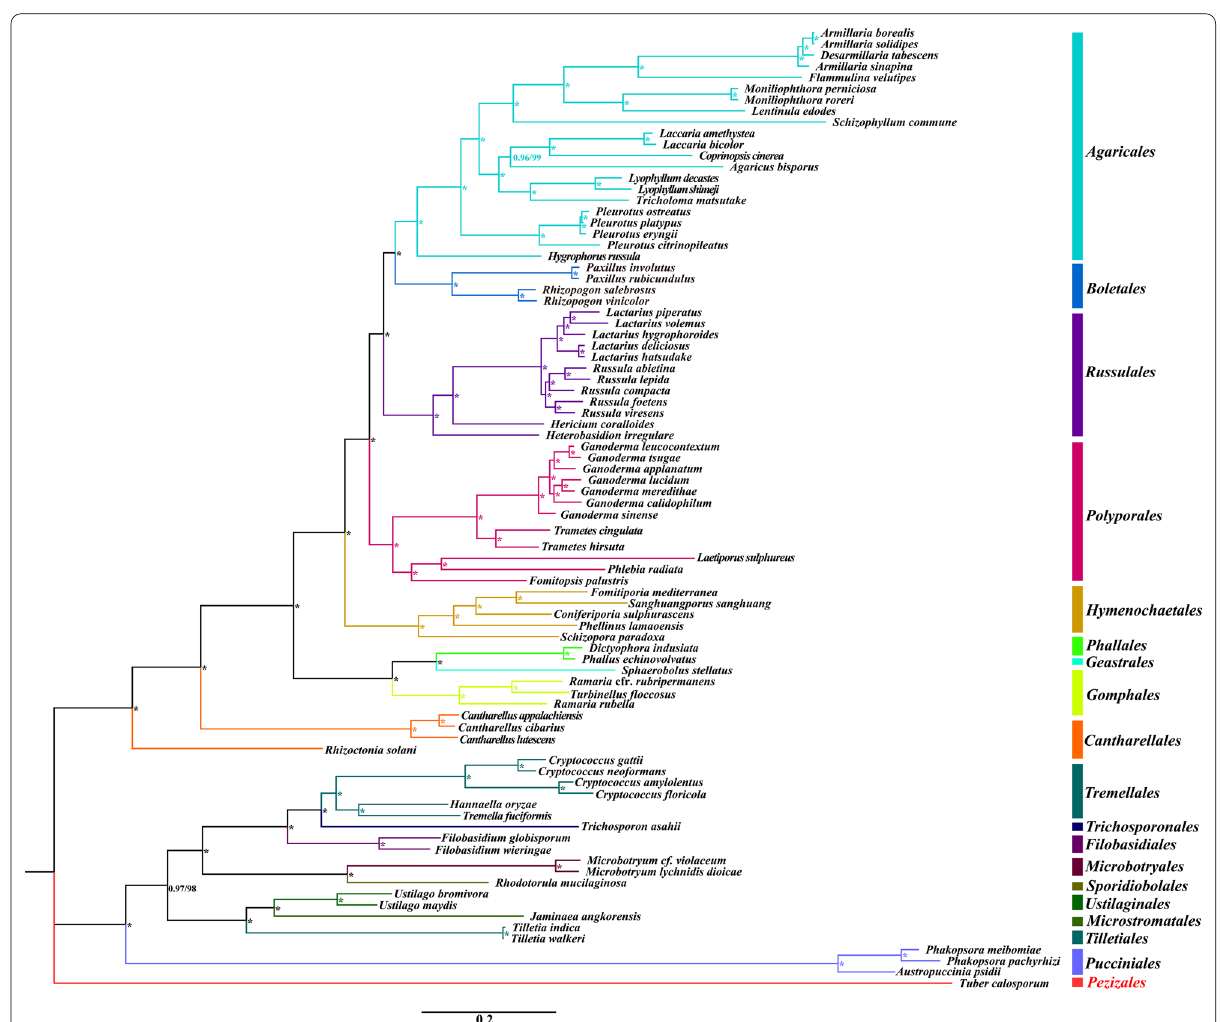
Fig. 9 Molecular phylogeny of 84 Basidiomycota species based on Bayesian inference (BI) and Maximum Likelihood (ML) analysis of 14 protein coding genes. Support values are Bayesian posterior probabilities (before slash) and bootstrap (BS) values (after slash). The asterisk on the evolutionary clades indicates that the BPP value is 1 and the BS value is 100. Species and NCBI accession numbers for mitogenomes used in the phylogenetic analysis are provided in Additional file 1: Table